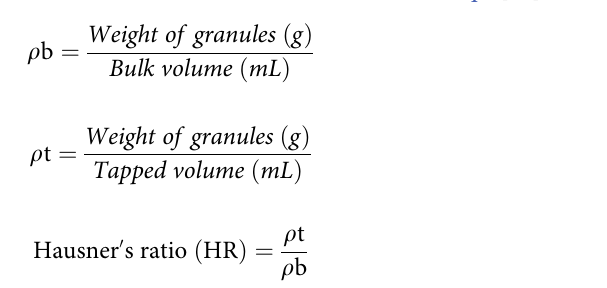
Weight of granules ð g Þ r b ¼ Bulk volume ð mL Þ Weight of granules ð g Þ r t ¼ Tapped volume ð mL Þ